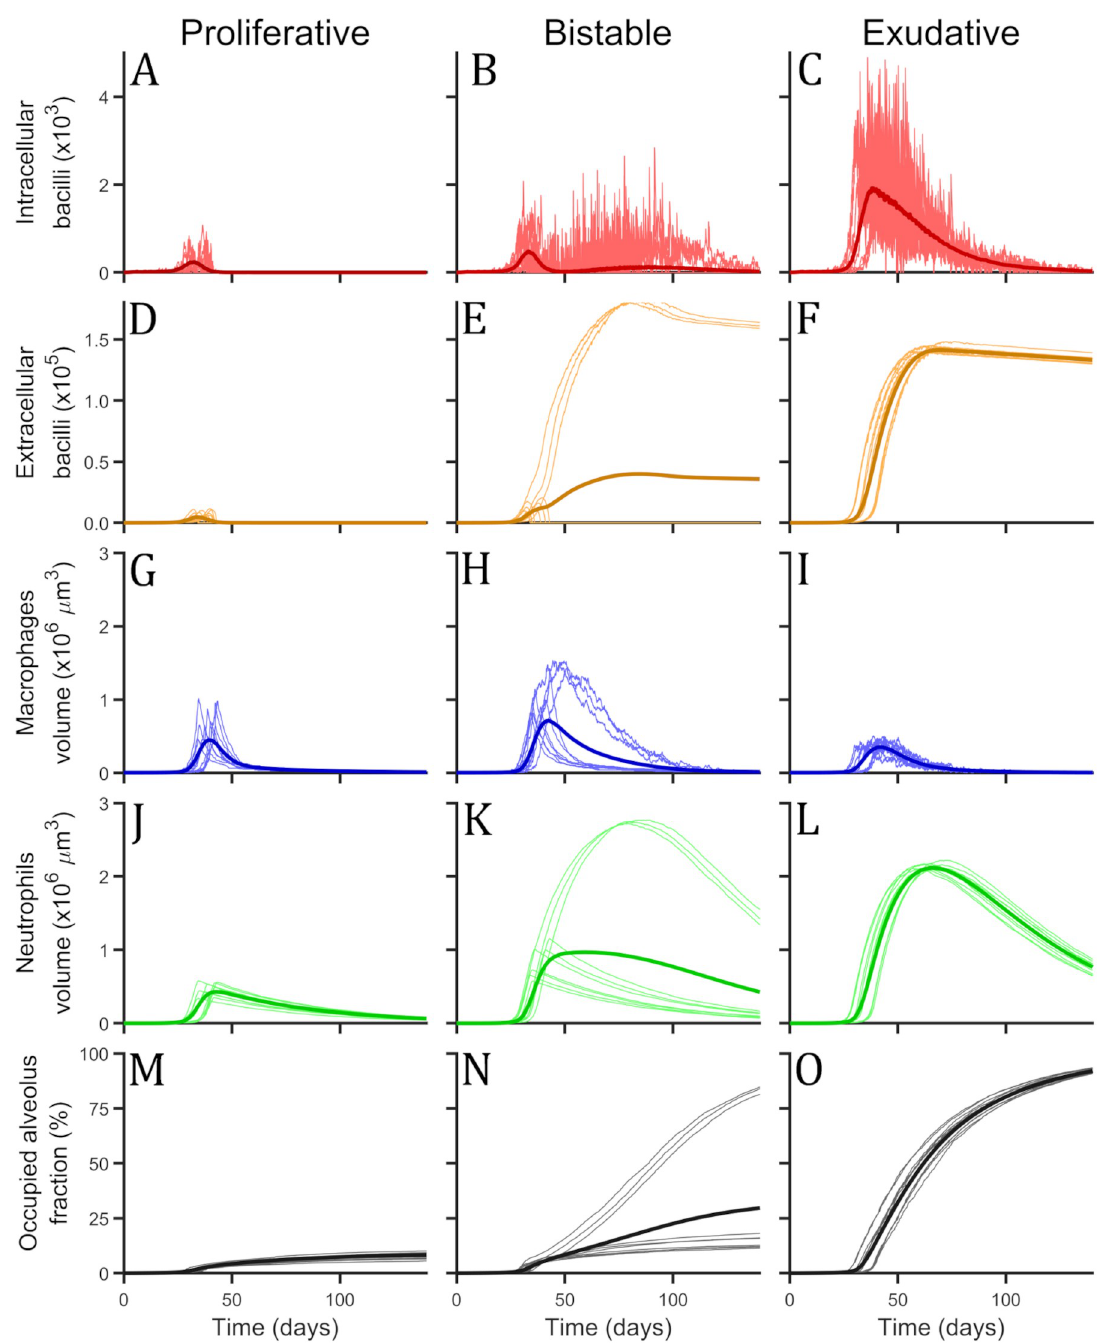
Fig 3. Single alveolus model simulations with three different set of parameters. (A, D, G, J, M) Proliferative set, (B, E, H, K, N) bistable set and (C, F, I, L, O) exudative set. For each set of parameters there can be seen the total amount of intracellular bacilli, in red (A, B, C), the total amount of extracellular bacilli, in orange (D, E, F), the total volume occupied by macrophages, in blue (G, H, I), the total volume occupied by neutrophils, in green (J, K, L) and the occupied alveolus volume fraction, in black (M, N, O). Thin and bright lines represent single simulations, 10 single simulations are shown as example for each set. Thick and dark lines are the mean value of 10000 simulations. Simulations were 200 days long, but only the first 140 are shown.